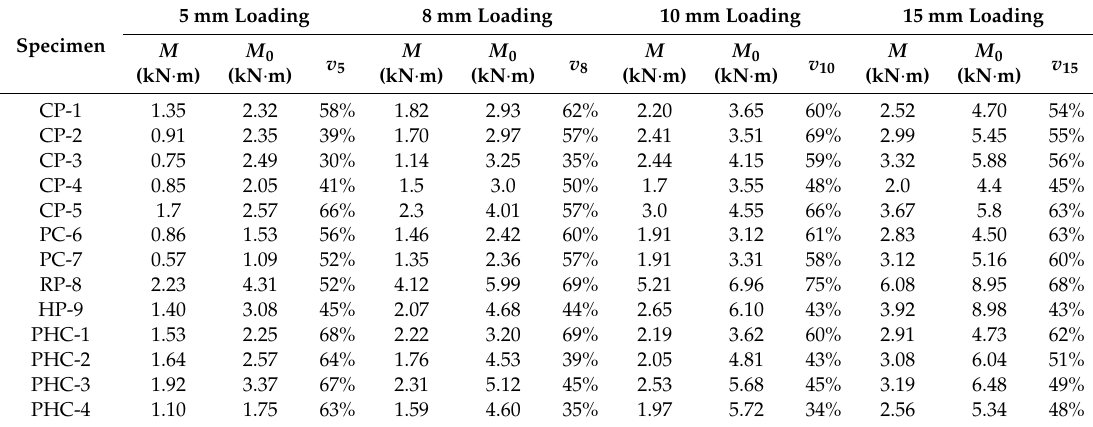
Table 5. Bending moments and bearing ratios of specimens at 0.7 m of buried depth.